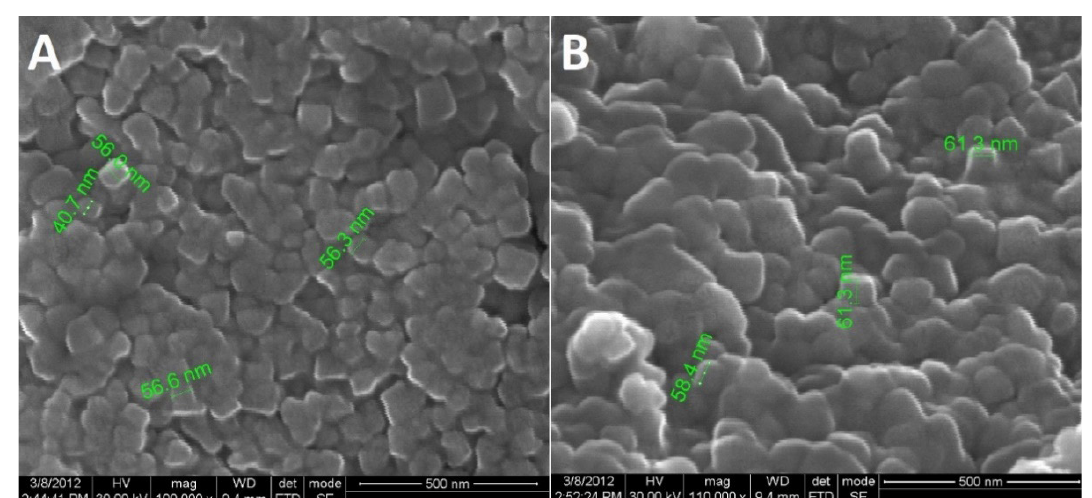
FIGURE 2 - Scanning Electron Micrograph of M. arvensis Linn. mediated silver nanoparticles. A, Spherical nanoparticles; B, cuboidal nanoparticles [Particles with sizes ranging 40-70 nm]